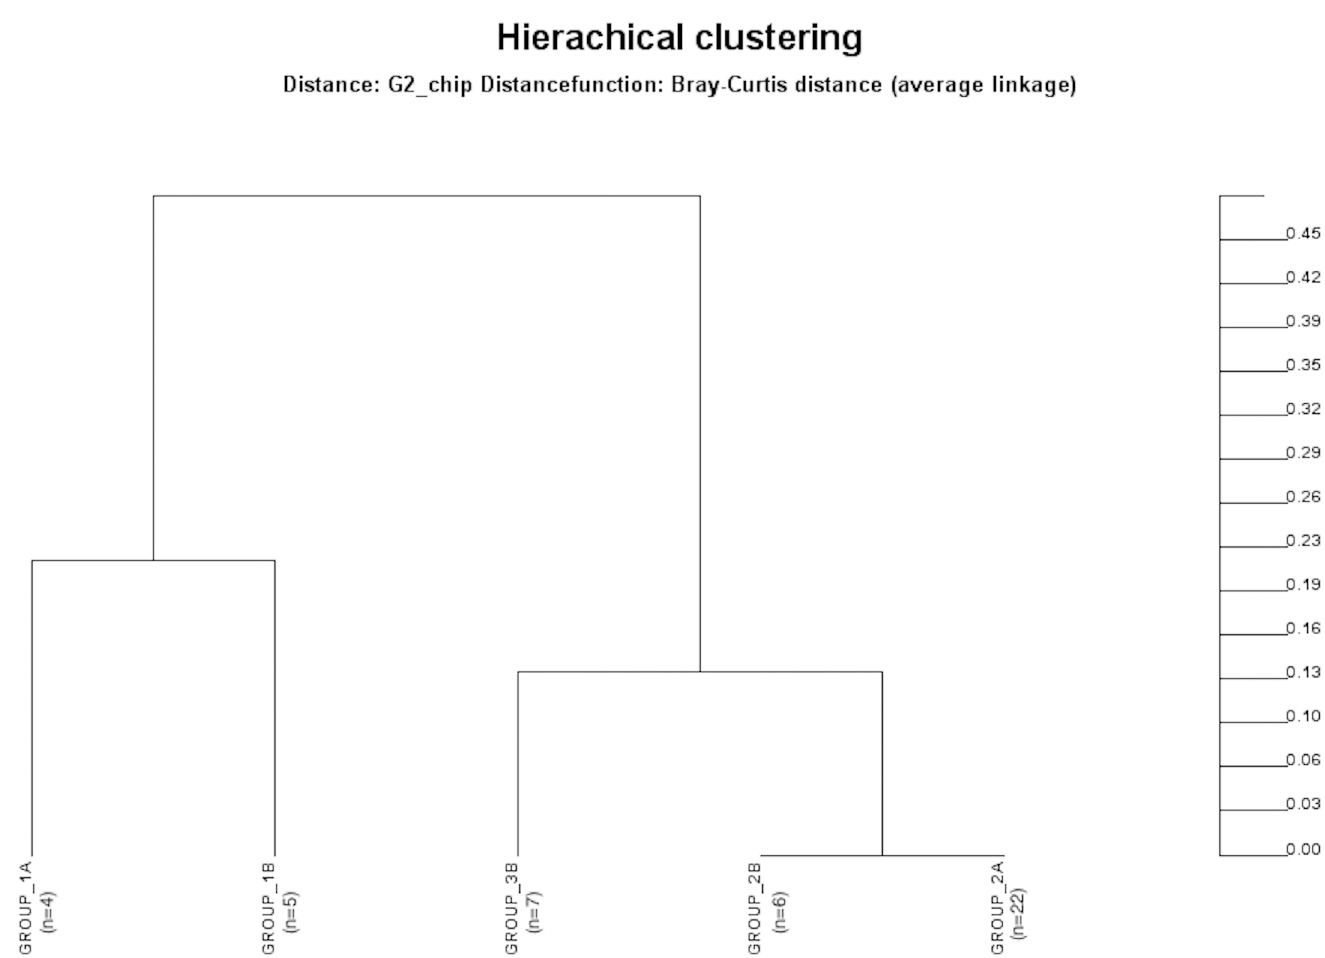
Fig 5. Bray-Curtis distances between study groups indicating differences in fungal species composition. Distance of zero indicates that groups are completely similar for every species. Distance of 1 indicates that groups are completely dissimilar and do not share any species. Group 1a, healthy adults; group 1b, healthy respiratory tract but with antibiotic therapy for extrapulmonary infection; group 2a, non-neutropenic intubated and mechanically ventilated ICU patients without antibiotic therapy; group 2b, non-neutropenic intubated and mechanically ventilated ICU patients with antibiotic therapy for extrapulmonary infection; group 3b, non-neutropenic intubated and mechanically ventilated ICU patients with antibiotic therapy due to